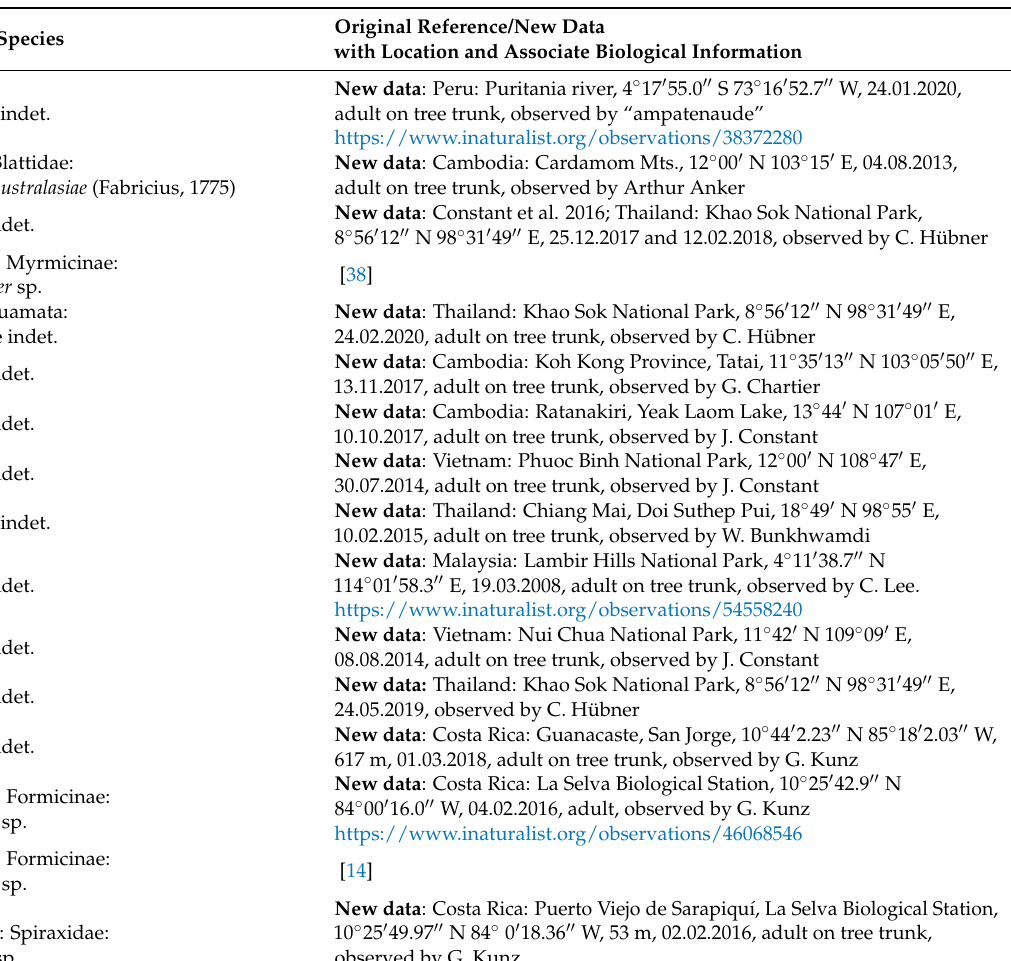
Phrictus quinquepartitus Figure 15c Distant, 1883 Polydictya thompsoni Constant and Pham,